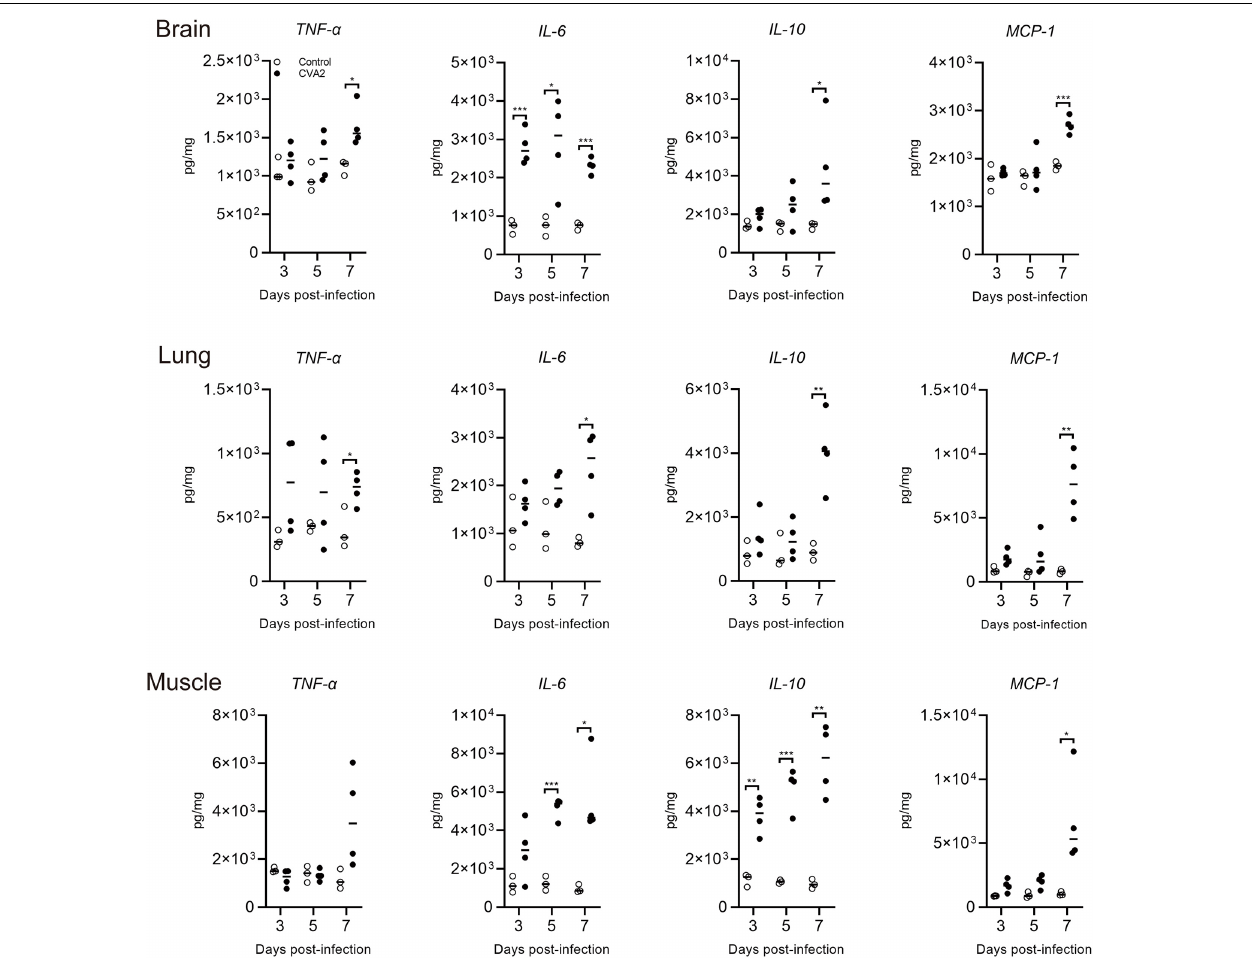
FIGURE 5 | Expression of tissue grinding lysate proinflammatory cytokines in CVA2-infected mice. The expression levels of IL-6, IL-10, TNF- α , and MCP-1 in tissue grinding lysate (brain, lung, and muscle) of the 5-day-old neonatal mice via i.m. inoculated with lethal doses of HN202009 at 3, 5, and 7 dpi were determined using mouse ELISA detection kits ( n = 4). * P < 0.05; ** P < 0.01; *** P <